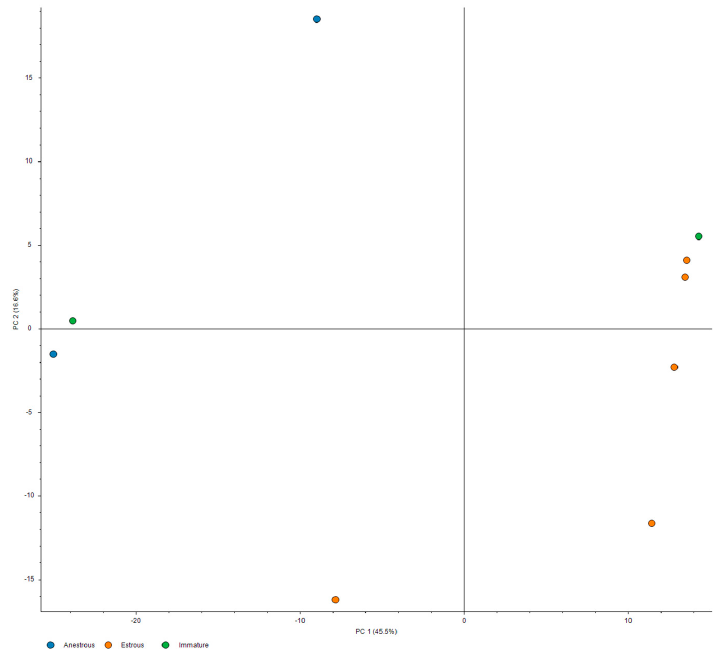
Figure 1. PCA analysis of the identified urinary proteins. The orange circle indicates the proteins from estrus stage, and blue circle indicates the proteins from anestrus urine samples, while immature samples are labeled in green.